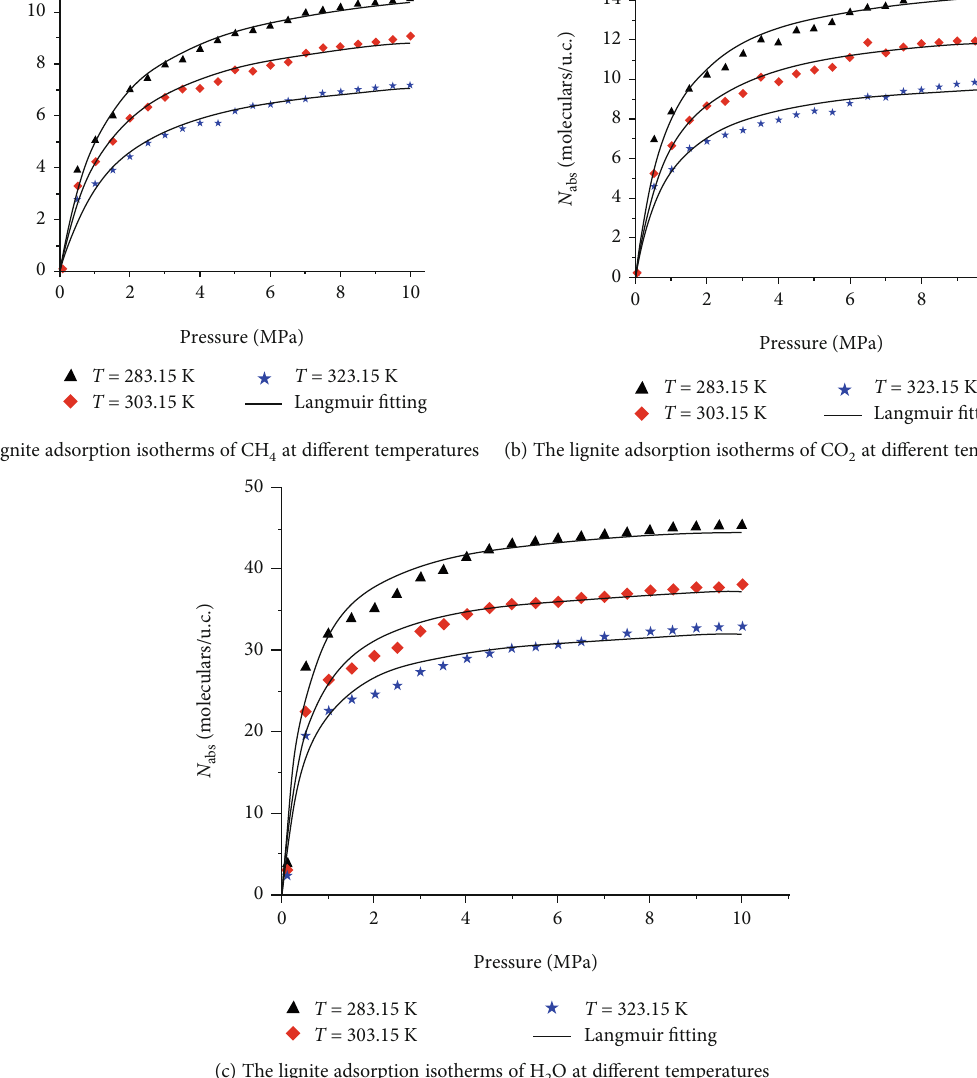
, CO , and H O at di ff erent 4 2 2